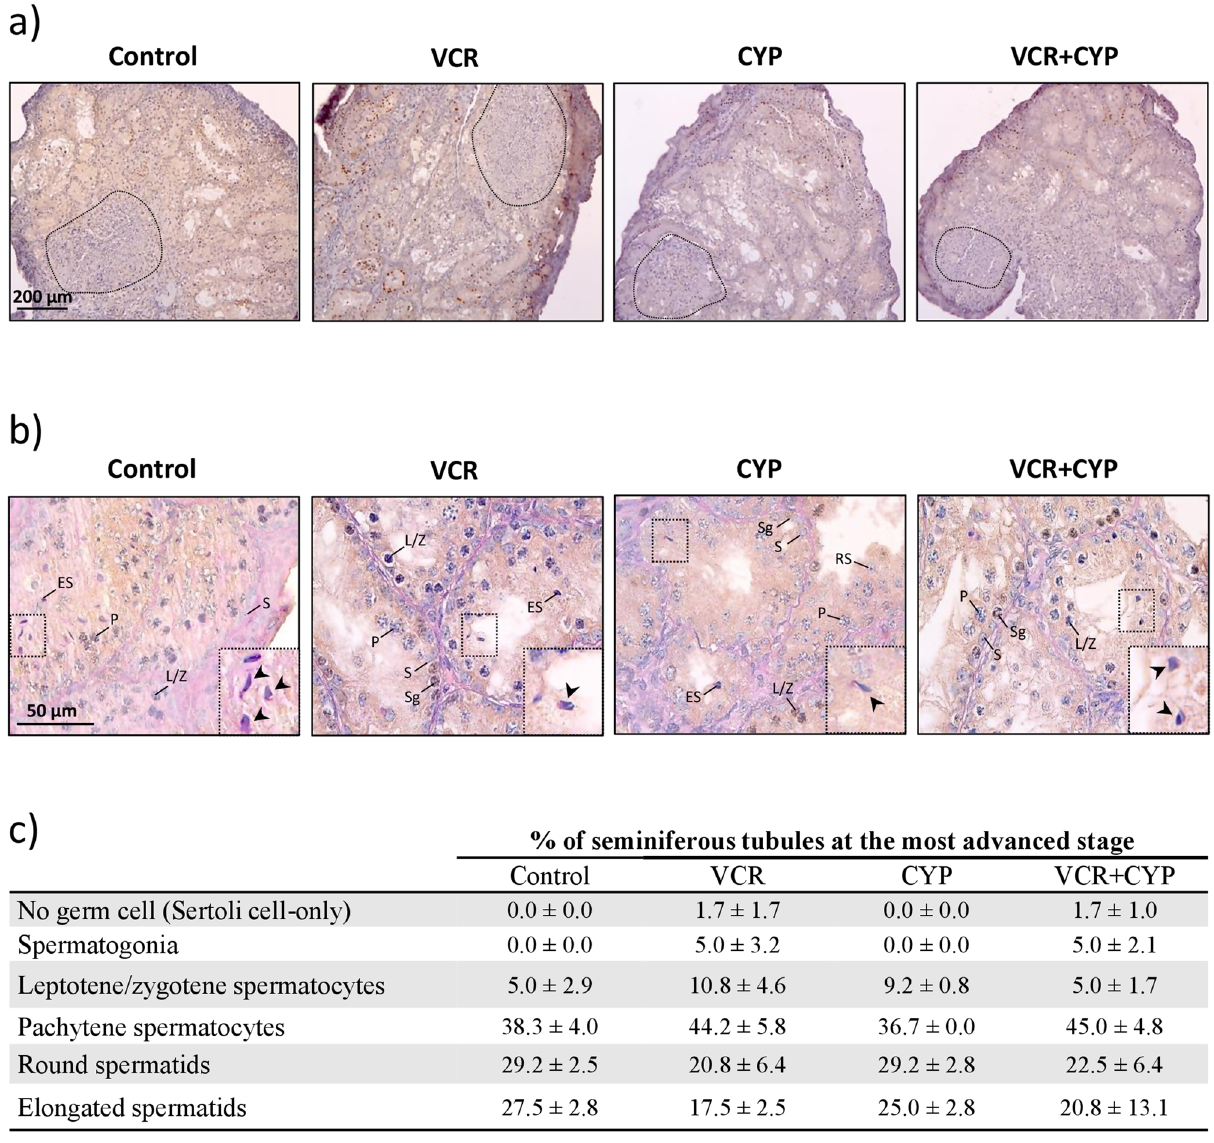
Figure 3. Progression of spermatogenesis following in vitro maturation of mouse testicular tissues treated by chemotherapy. ( a ) Microscopy images showing the general appearance of testicular tissue exposed to monochemotherapy (VCR or CYP), polychemotherapy (VCR+CYP) or unexposed (control) following 30 days of in vitro maturation. The necrotic area in cultured tissues has been delimited by dotted lines. ( b ) TRA98 immunostaining associated with Periodic Acid Schiff reaction was performed to visualize the progression of spermatogenesis after 30 days of organotypic culture, by detecting TRA98+ germ cells (spermatogonia, leptotene/zygotene and pachytene spermatocytes) and the pink-labelled acrosome (PAS+) of spermatids in control, CYP, VCR and VCR+CYP-treated mice. Intratubular cells were identified as: S for Sertoli cells (irregular TRA98- blue nuclei close to the basement membrane), Sg for spermatogonia (smooth spherical TRA98+ brown nuclei close to the basement membrane), L/Z for leptotene/zygotene spermatocytes (irregular spherical TRA98+ brown nuclei with condensed chromatin), P for pachytene spermatocytes (irregular spherical TRA98+ brown nuclei with highly condensed chromatin), RS for round spermatids (regular small round TRA98- blue nuclei and PAS+ acrosomal cap) or ES for elongated spermatids (elongated TRA98- blue nuclei with highly condensed chromatin and PAS+ acrosomal cap). Panels on the lower right corner represent a higher magnification of elongated spermatids ( ). ( c ) Percentage of seminiferous tubules at the most advanced differentiation stage of spermatogenesis after in vitro maturation of testicular tissues from mice exposed to VCR, CYP, VCR+CYP or unexposed (control) during the prepubertal period. Data are presented as means ± SEM with n = 4 testicular explants for each group. A value of * P < 0.05 was considered statistically